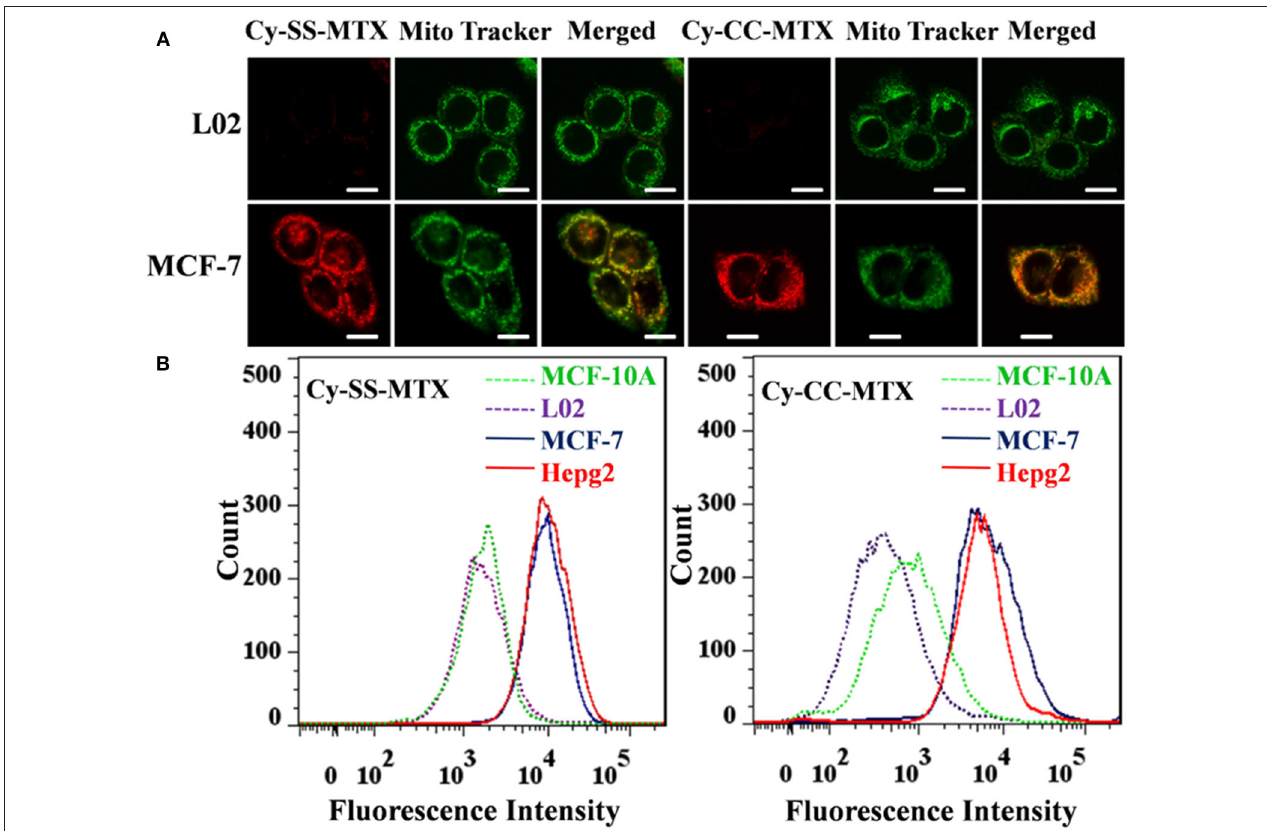
FIGURE 4 | (A) Fluorescence confocal microscope images of L02 normal cells and MCF-7 cancer cells cultured with Cy-SS-MTX/Cy-CC-MTX (5 µ M) for 0.5h respectively. Images were obtained using an excitation wavelength of 633nm (Cy-SS-MTX/Cy-CC-MTX) and 488nm (Mito). Scale bar, 10 µ m. (B) Flow cytometry